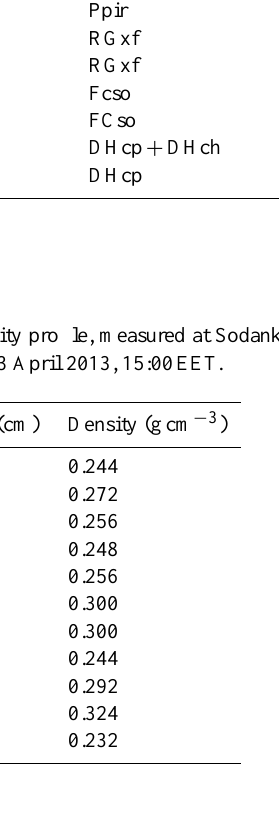
For most FIGIFIGO measurements, the particles were dis- tributed manually over an area of 0.5 m 2 using a salt shaker filled with a measured amount of